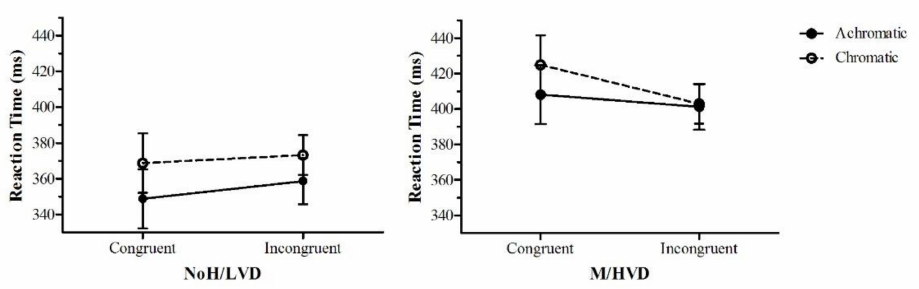
Figure 7. Group, Colour and Congruency effects for conditions one, three, four and six. RTs were averaged over 12 repeat trials for each participant. The error bars represent ± 1 SEM